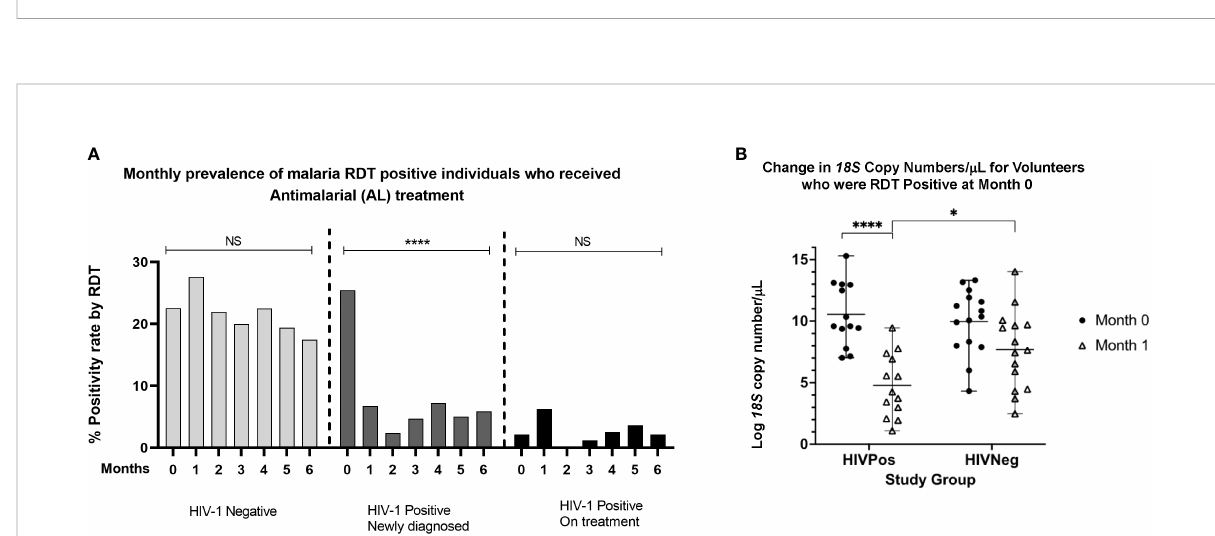
FIGURE 2 (A) Monthly prevalence rates for individuals who were RDT positive and who received AL treatment across the three study groups. Signi fi cant reductions in parasite prevalence were seen among the HIV-1 positive newly diagnosed following initiation of ART/TS treatment but not among the HIV-1 negative group and the HIV-1 positives on treatment (one way ANOVA with Tukey ’ s HSD posthoc analysis. (B) Comparison of 18S copy numbers for HIV positive and HIV negative volunteers who were RDT positive at month 0 and month 1. There were signi fi cant